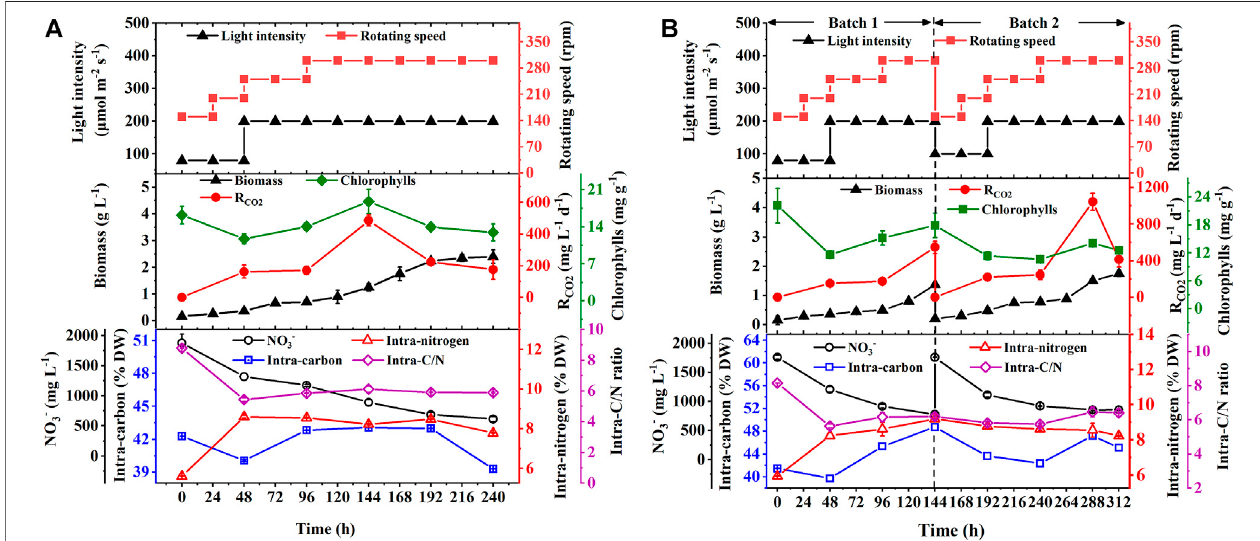
FIGURE 2 | Biomass production, chlorophyll contents and CO 2 fi xation rate (R CO2 ), NO 3 − consumption, and the intracellular contents of carbon and nitrogen with theirratiosinbiomassduringthebatch (A) andrepeatedfed-batchcultures (B) ofautotrophic C.subellipsoidea in5-Lphoto-fermentersunderthecontrollableoperation parameters.